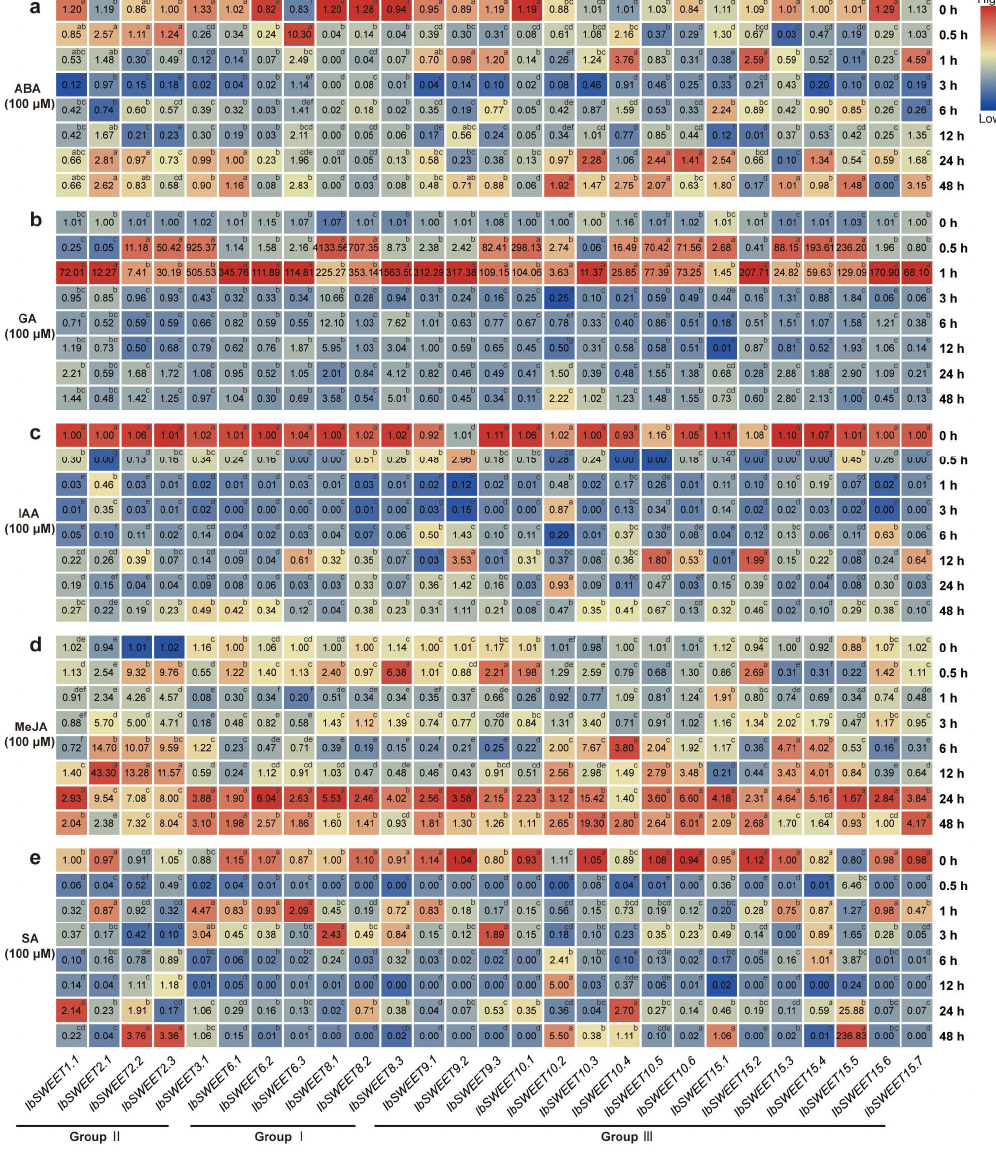
Figure 10. Gene expression patterns of IbSWEETs in response to different phytohormones (( a ) ABA, ( b ) GA, ( c ) IAA, ( d ) MeJA, and ( e ) SA) of I. batatas. The values were determined by qRT-PCR from three biological replicates consisting of pools of three plants, and the results were analyzed using the comparative C T method. The expression of 0 h in each treatment was considered as “1”. The fold changes are shown in the boxes. Different lowercase letters indicate a significant difference of each IbSWEET at p < 0.05 based on Student’s t -test.